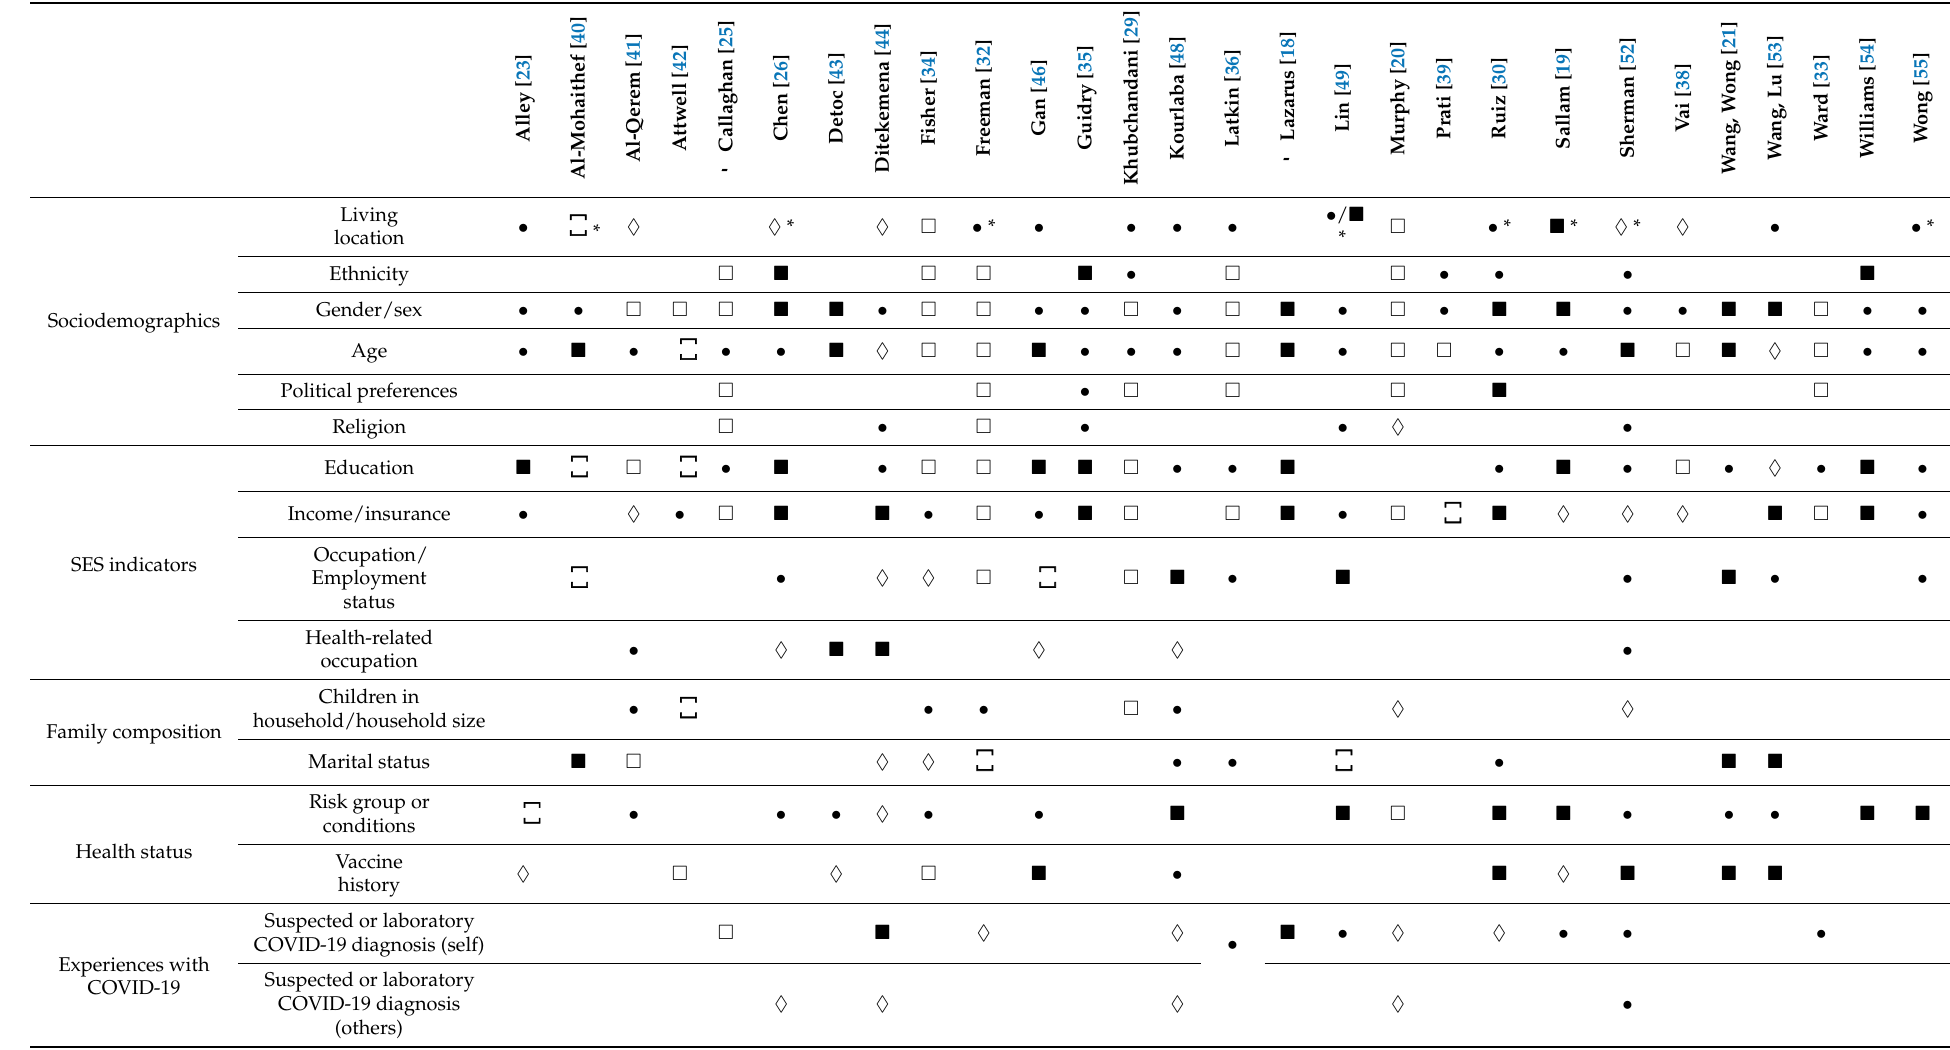
Table 4. Selected articles (sorted by first author) and studied determinants of vaccine acceptance or hesitancy and/or refusal.